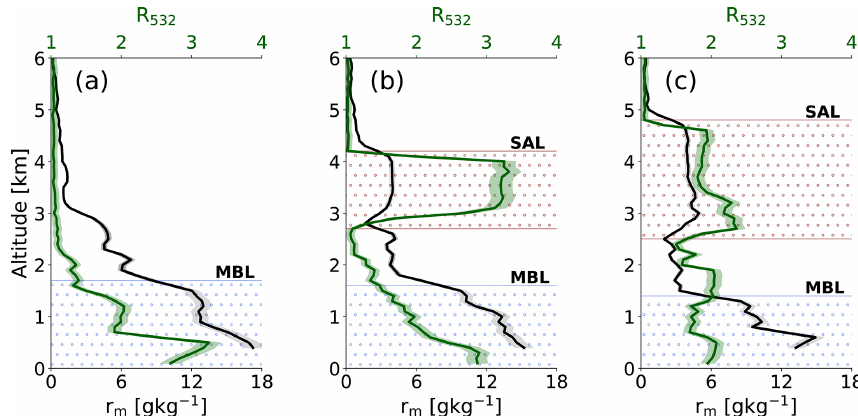
Figure 3. Averaged vertical profiles of backscatter ratio ( R 532 ) and water vapor mass mixing ratio ( r m ) for cases (a) , (b) and (c) . Shaded: estimated measurement uncertainties. Colored height intervals highlight the approximate ranges of the Saharan air layer (SAL; dotted orange) and marine boundary layer (MBL; dotted light